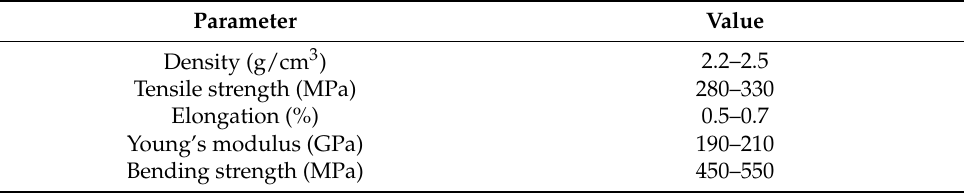
Figure 1. Surface morphology of the SiC f /SiC composite ( × 80). Table 1. Properties of SiC f /SiC composite